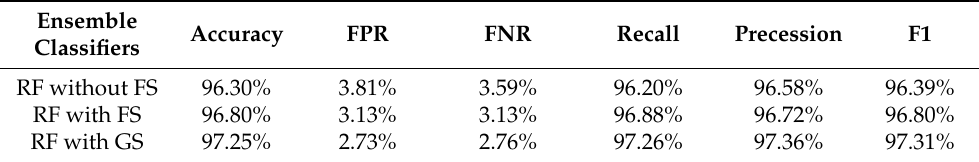
Table 3. Performance of the CTI-MURLD model with and without feature selection and with grid search best-found